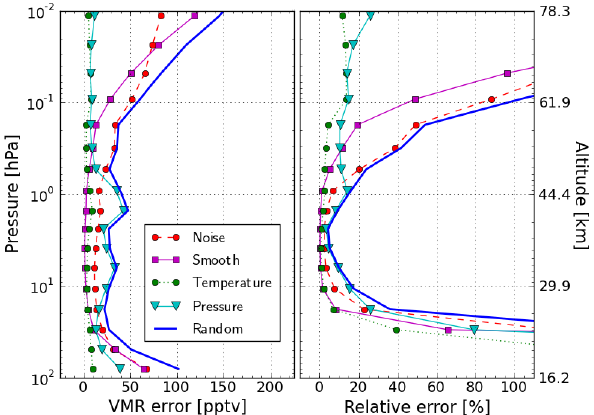
Fig. 4. Summary of the random errors for a single-scan observation. Red: E noise . Purple: E smooth . Green: Error from temperature profile; the uncertainties are 3, 10, 30 and 50K for the troposphere (below 11km), the stratosphere (11–59km), the mesosphere (59–96km) and the thermosphere (above 96km). Cyan: Error from pressure profile (10%). Blue: Total random error.